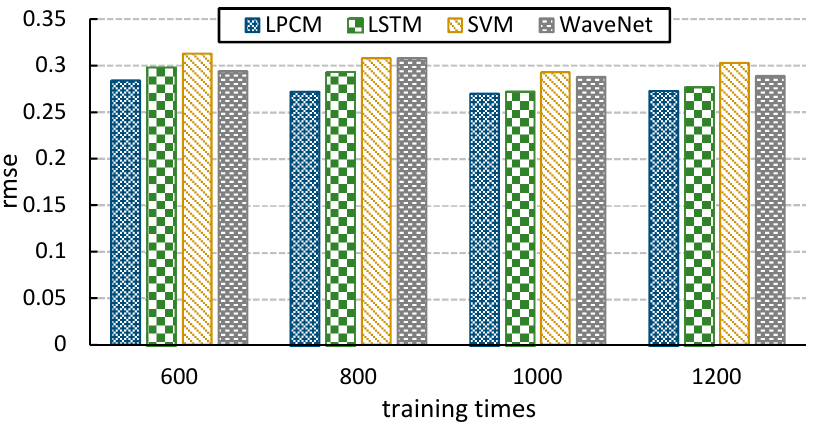
Figure 12. Rmse of different models under different training times.